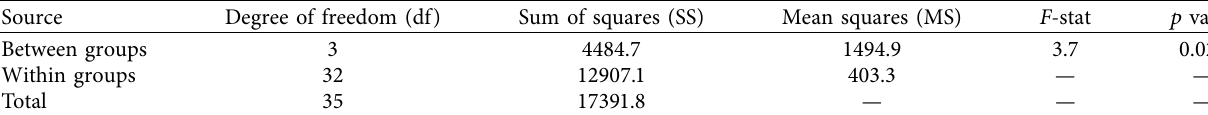
Table 6: ANOVA table for SOC stocks in different forest types.